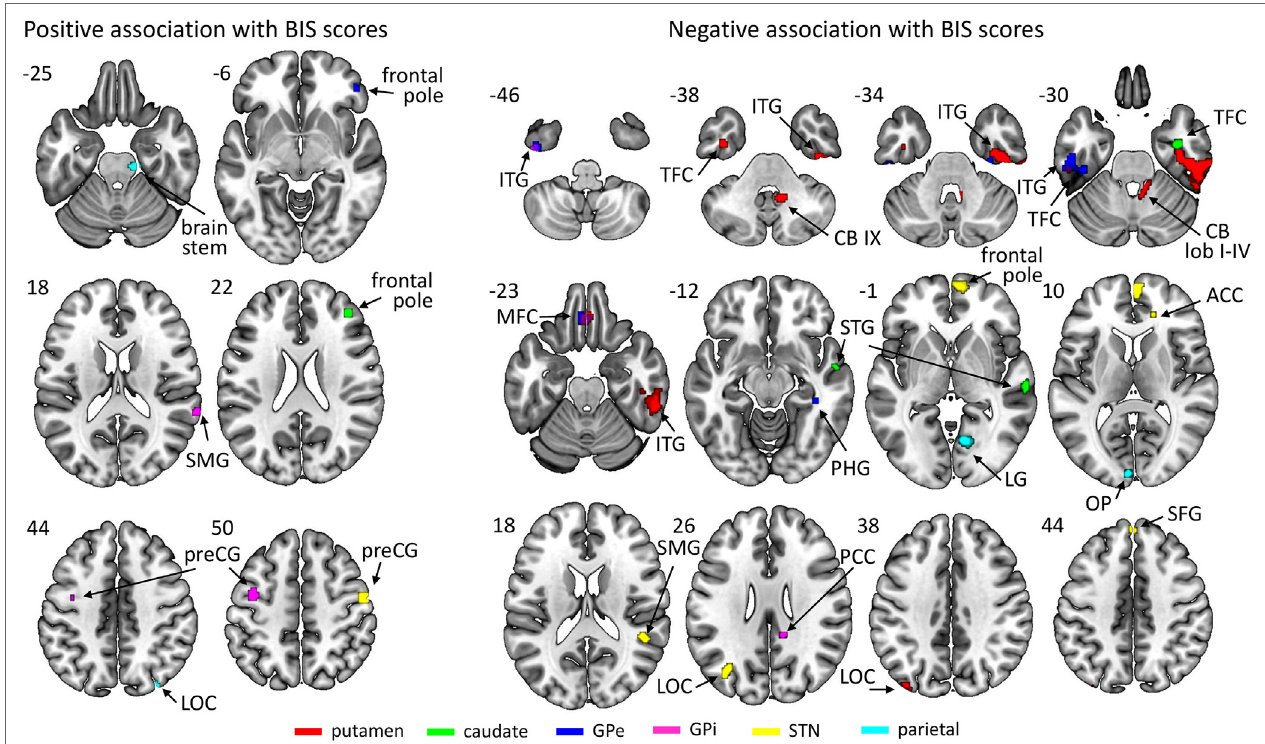
FigUre 3 | Regions of which the connectivity strength with their respective region of interest was associated positively (left) or negatively (right) with Barratt Impulsiveness Scale (BIS) scores across participants. The key for the abbreviations can be found in the notes of Table 3